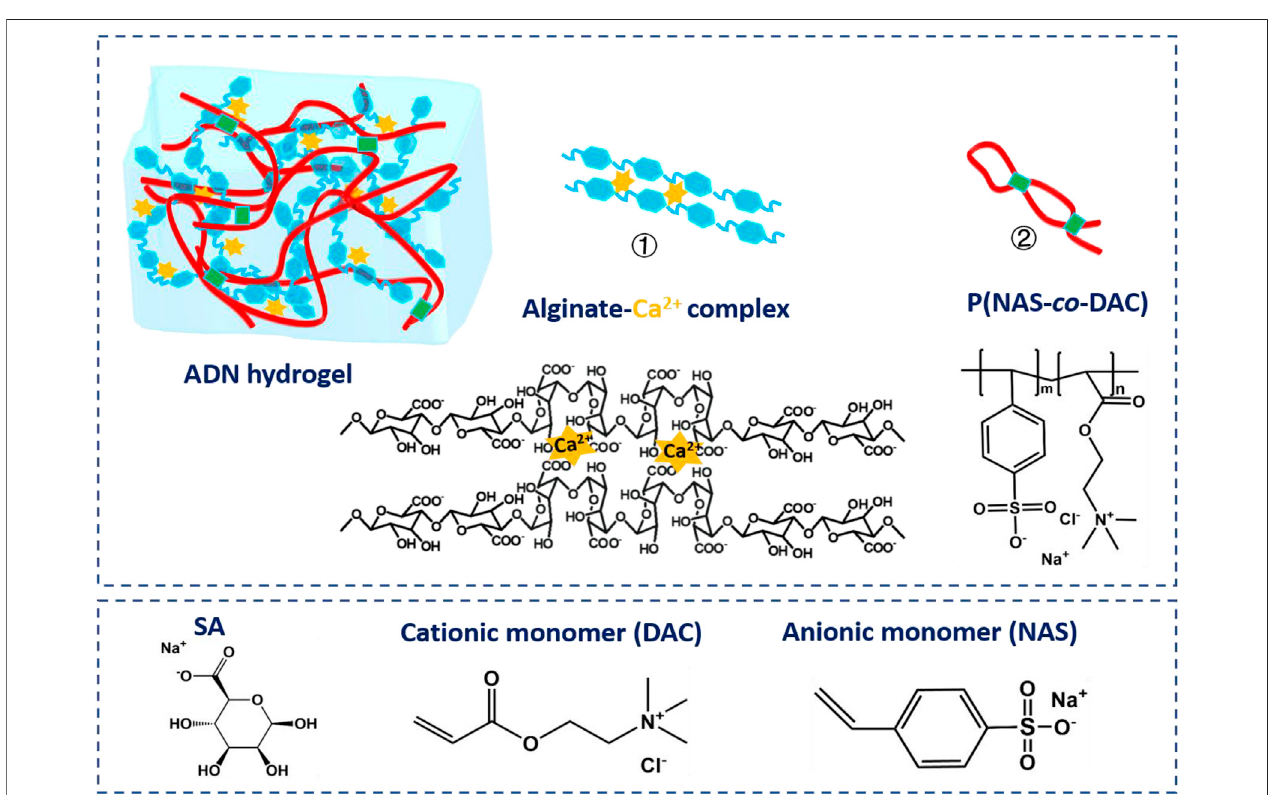
FIGURE 1 | Schematic of the preparation process of the ADN